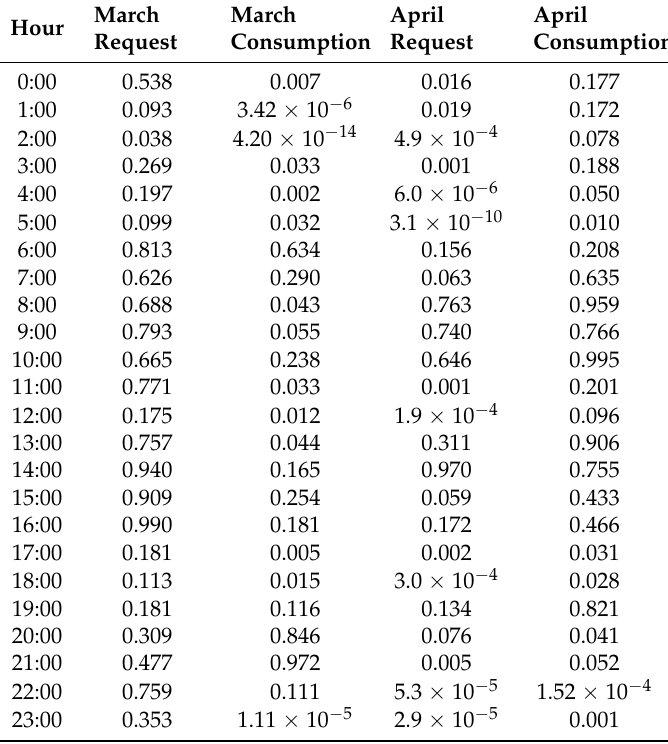
Table 1. P -values obtained by the t -student test of the null hypothesis such that the mean of the real data are equal to the mean of the generated by SHtsG data for each hour of the day. Specifically, real data and synthetic data are compared both for the water request and consumption in March (training) and April (validation),